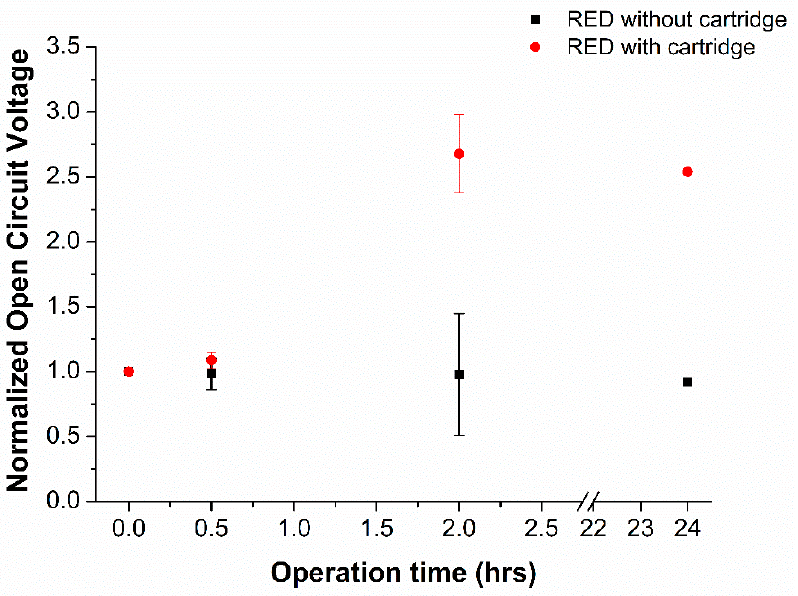
Figure 3. Open circuit voltage (OCV) values recorded for RED biopower cell operations with and without the salt cartridge. N = 3 for 0–2 h and n = 1 for 24 h.